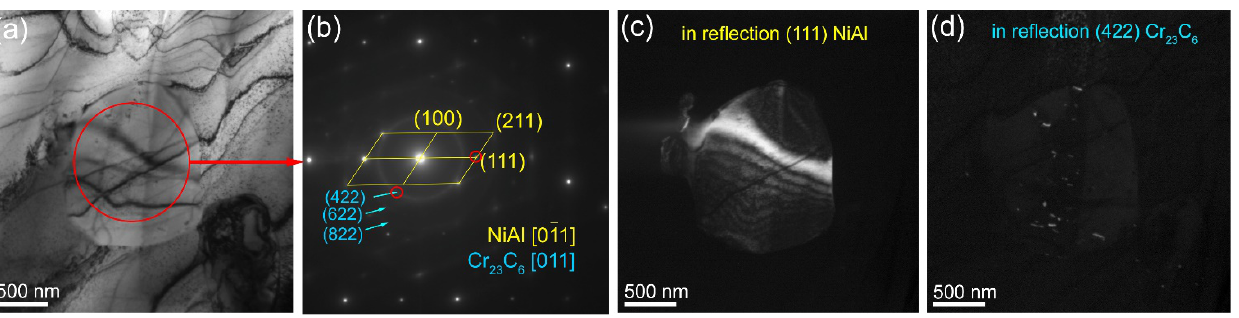
Figure 10. Bright-field TEM images of NiAl grain with carbide precipitates ( a ) in 15% Ud composite. SAED pattern ( b ) and dark-field images of NiAl grain ( c ) and M 23 C 6 carbides ( d ) in reflections (111) NiAl and (422) Cr23M6 ,